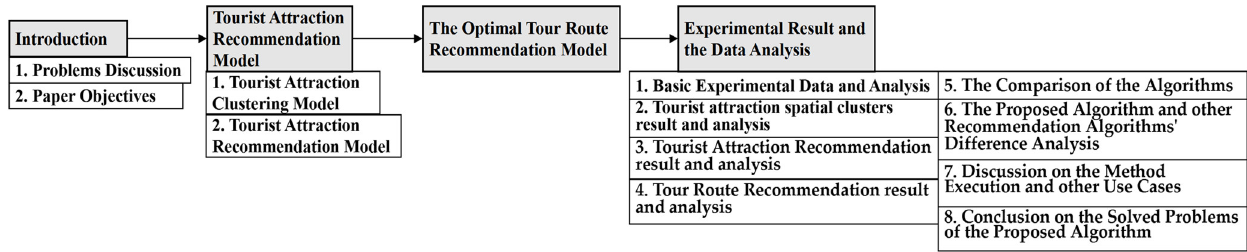
Figure 1. The sequence of the paper content.